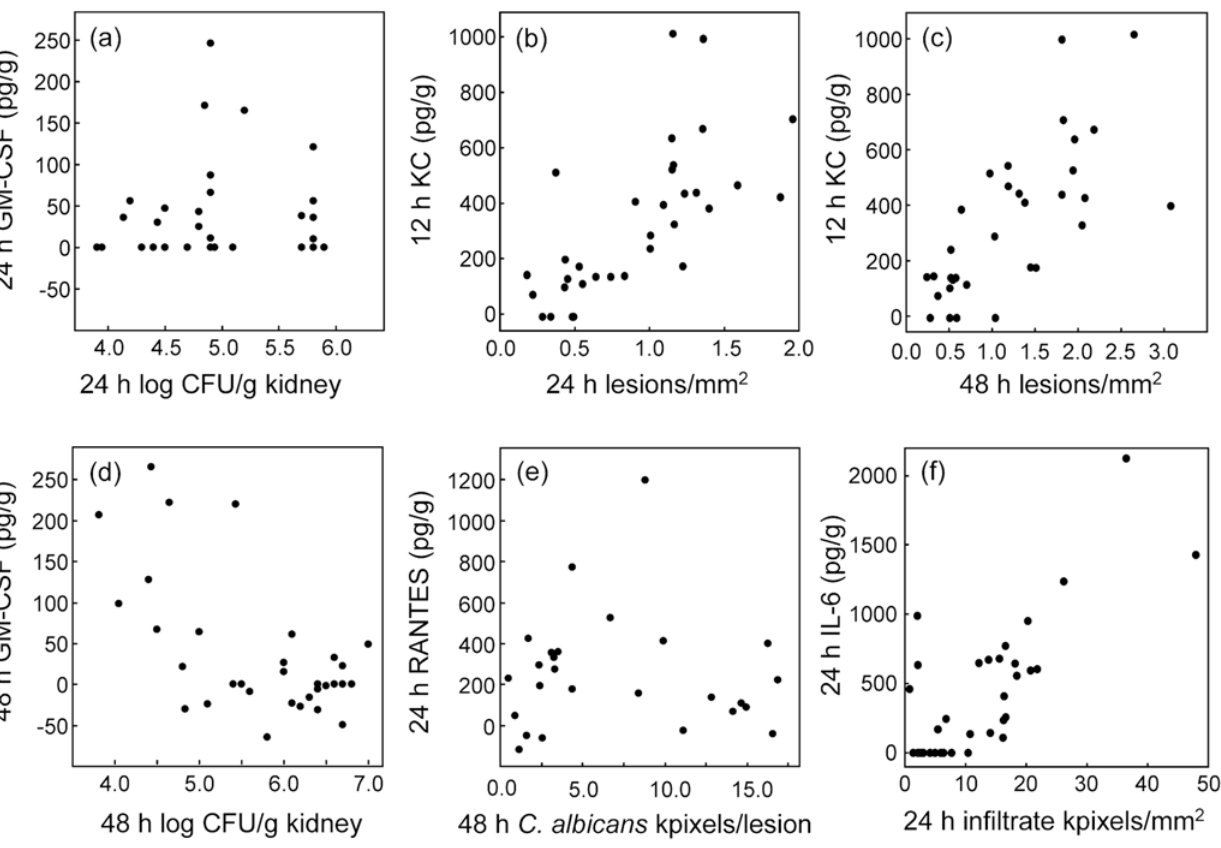
Figure 7. Scatterplots of cytokine or chemokine concentrations in kidney samples vs. lesion parameters for animals infected with 11 C.albicans strains: 3 points per strain. (a) GM-CSF at 24 h vs viable fungal burdens at the same time; r =0.08, p =0.33. (b) KC at 12 h vs lesion density at 24 h; r =0.84, p , 0.001. (c) KC at 12 h vs lesion density at 48 h; r =0.67, p , 0.001. (d) GM-CSF at 48 h vs viable fungal burdens at the same time; r = 2 0.61, p , 0.001. (e) RANTES at 24 h vs mean C. albicans pixels per PAS-positive lesion; r = 2 0.05, p =0.41. (f) 24 h IL-6 vs mean host infiltrate pixels per mm 2 section; r =0.77, p , 0.001.